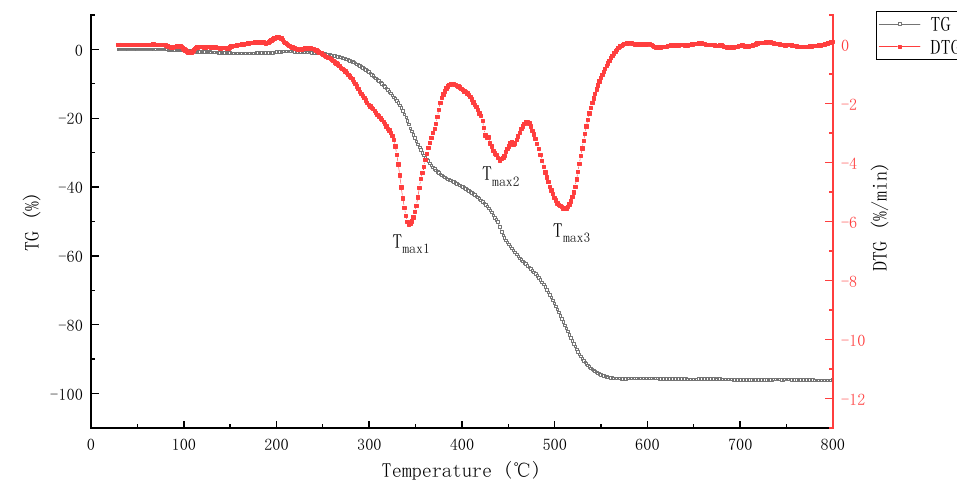
Figure 1. TG and DTG rate curve of epoxy asphalt.